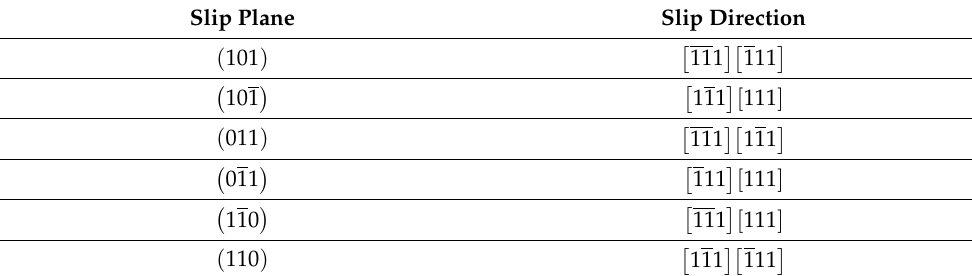
Table 5. Main slip systems and corresponding parameters of β -Ti